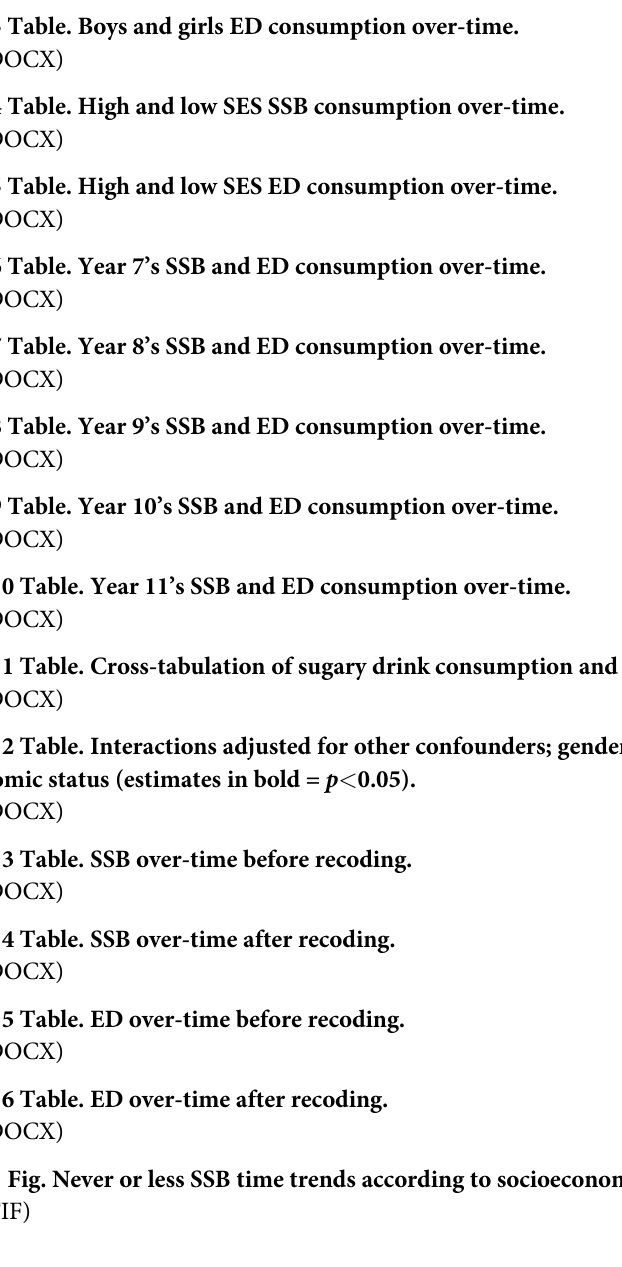
S1 Table. Sample characteristics of the study participants (11–16 years) between 1998 and 2017 (n = 176,094).